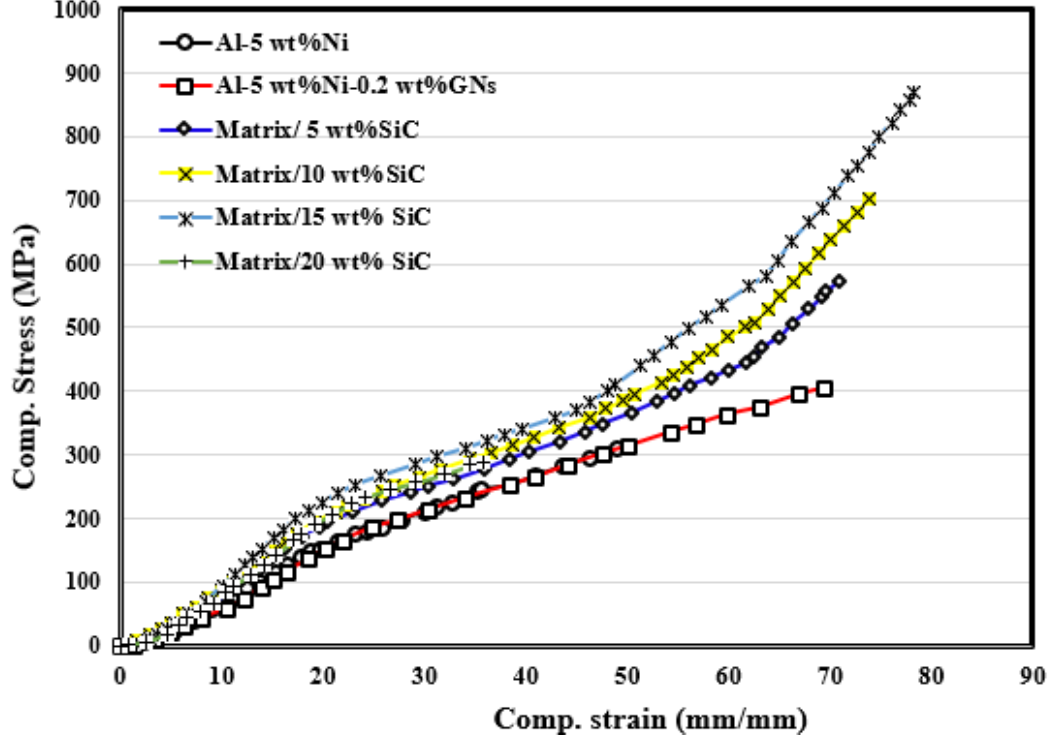
Figure 6. Stress – strain curves of the fabricated nanocomposites. Figure 6. Stress–strain curves of the fabricated Table 3. C ompressive stress and strain of the tested samples. Sample No.